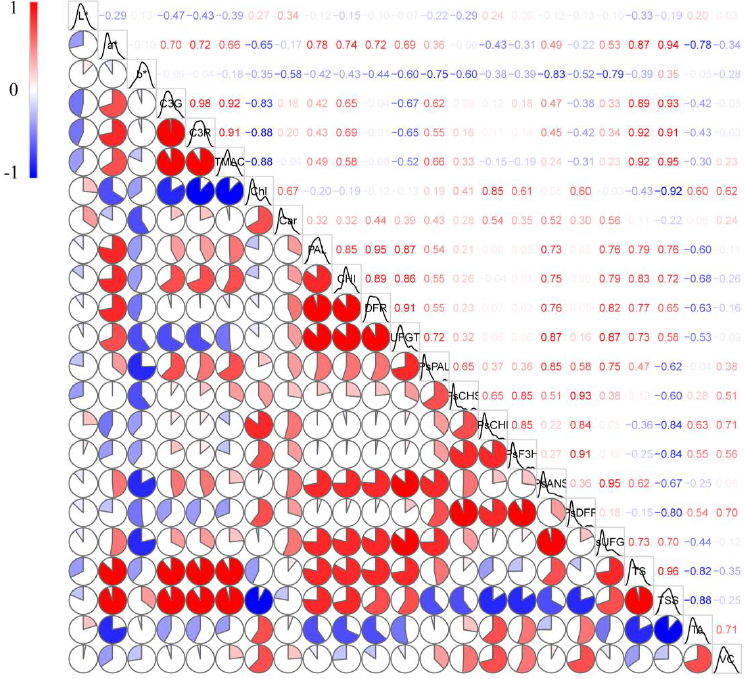
Figure 7. Pearson’s correlation coefficients of fruit quality parameters, pigment content, anthocya- nin − synthesis − related enzymes, and gene correlation in CHL and CHR plums. The color bar indi- cates the correlation coefficient, blue indicates a negative correlation, and red indicates a positive correlation. positive